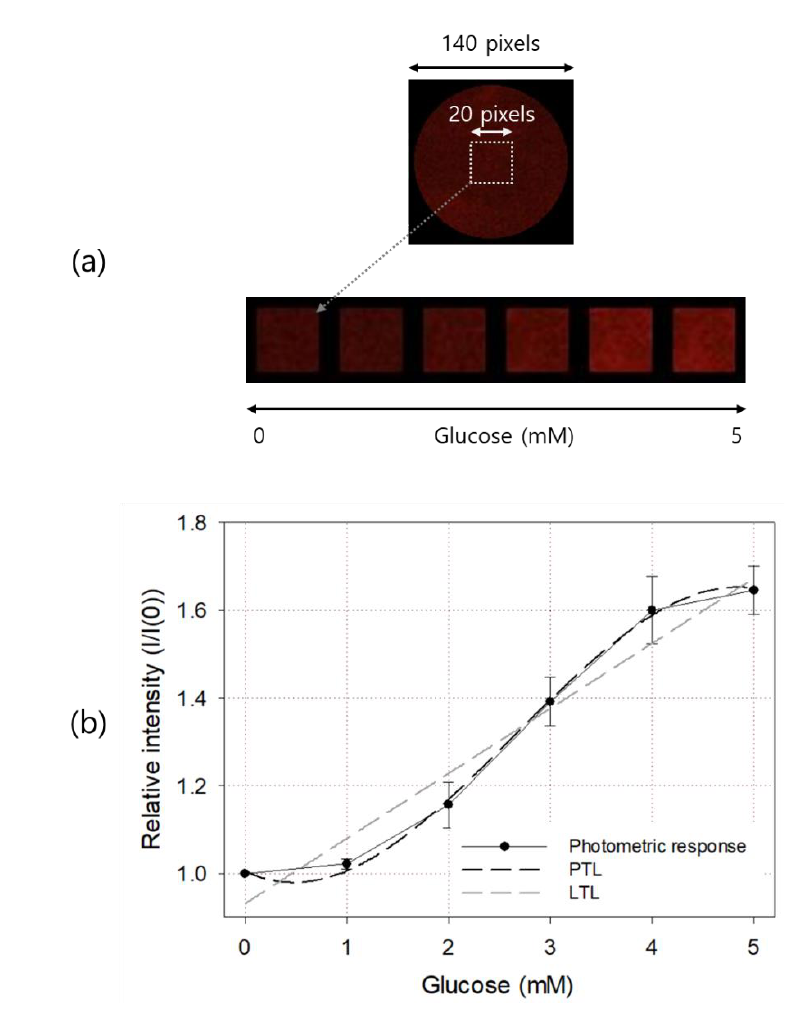
Figure 6. Color images ( a ) and photometric responses ( b ) of the manufactured glucose sensor. In ( b ), LTL and third-degree PTL for the response curve are also shown. The result is an average of five measurements, and the error bar represents the standard deviation.